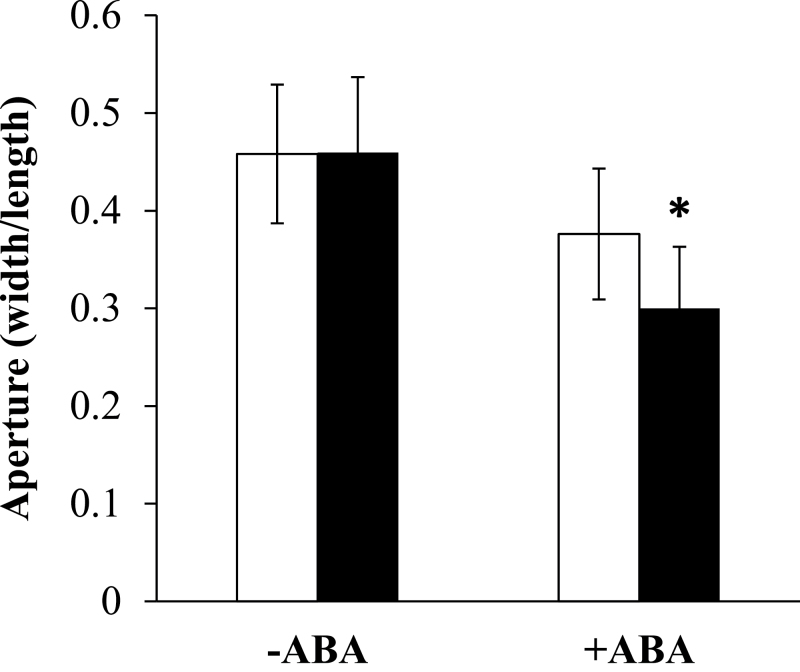
ABA-induced stomatal closure in WT (white columns) and 35S:IgASE1 transgenic plants (black columns). Data represent the mean ± SE from three independent experiments (n = 50–60 per experiment). *P < 0.05 in a Student’s t test.